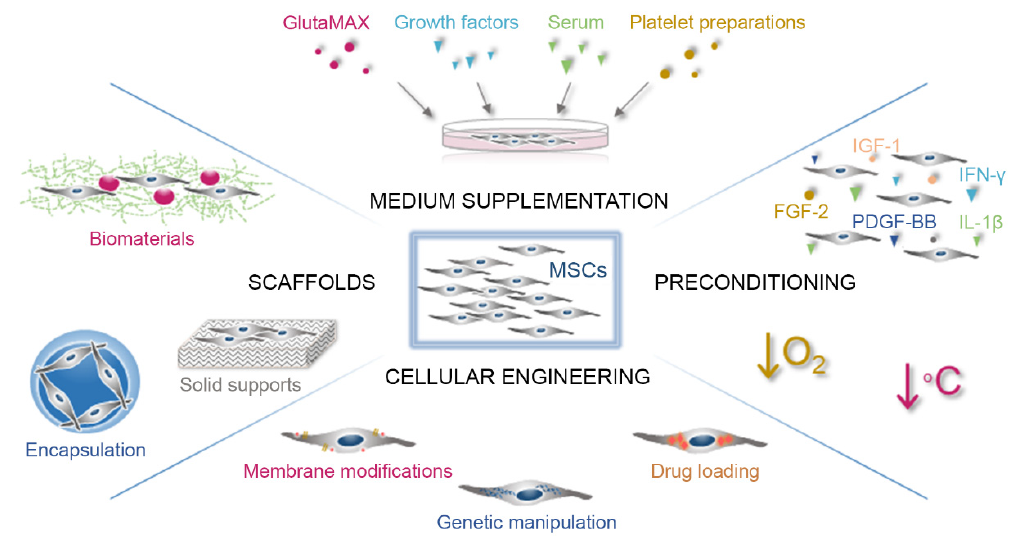
Figure 2. Strategies to potentiate the therapeutic properties of MSCs. Among the most common approaches to improve the MSC therapeutic effects are the use of supplements in the culture media, MSC preconditioning, the use of scaffolds during the seeding or transplantation process and the engineering of MSCs.